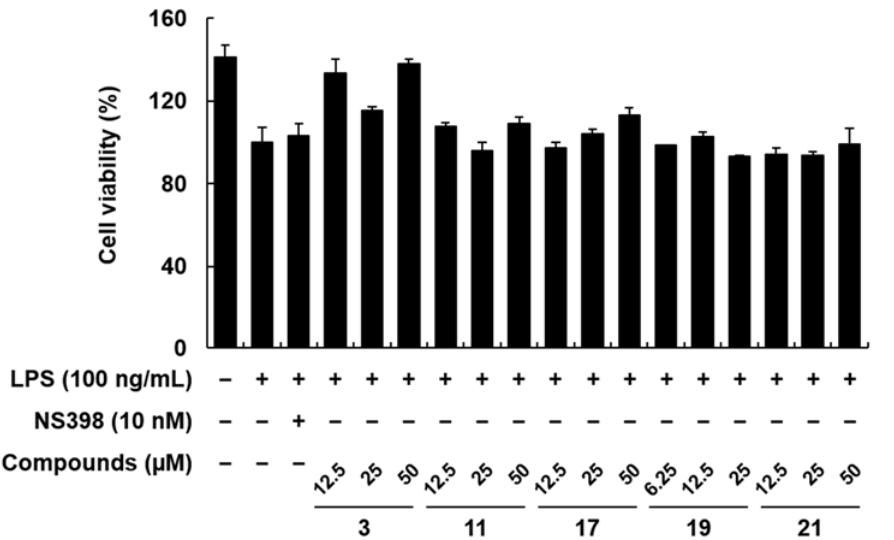
Figure 2. Effects of compounds 3 , 7 , 11 , 17 , 19 , and 21 on cell viability in LPS ‐ stimulated RAW 264.7 macrophages. The cells were treated with compounds at concentrations of 6.25, 12.5, 25, and 50 μ M and incubated for 24 h.